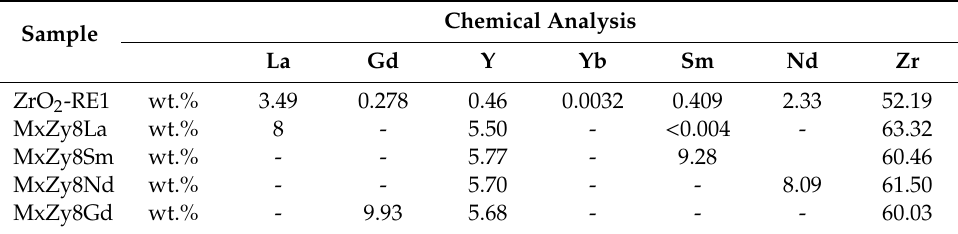
Table 7. Chemical composition of REO-doped ZrO 2